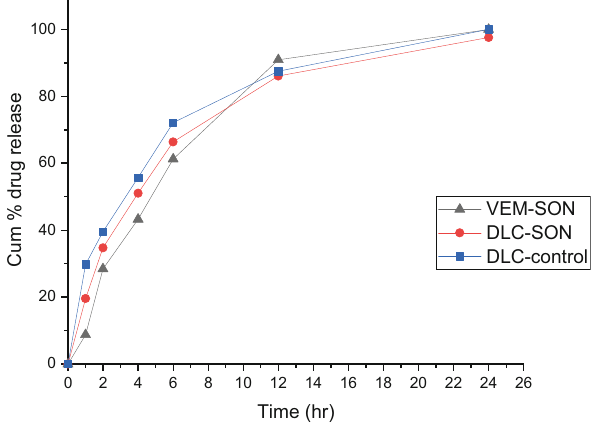
Figure 8. In vitro VEM release from DLC-SON and DLC-control incomparison to VEM-SON in PBScontaining 1%